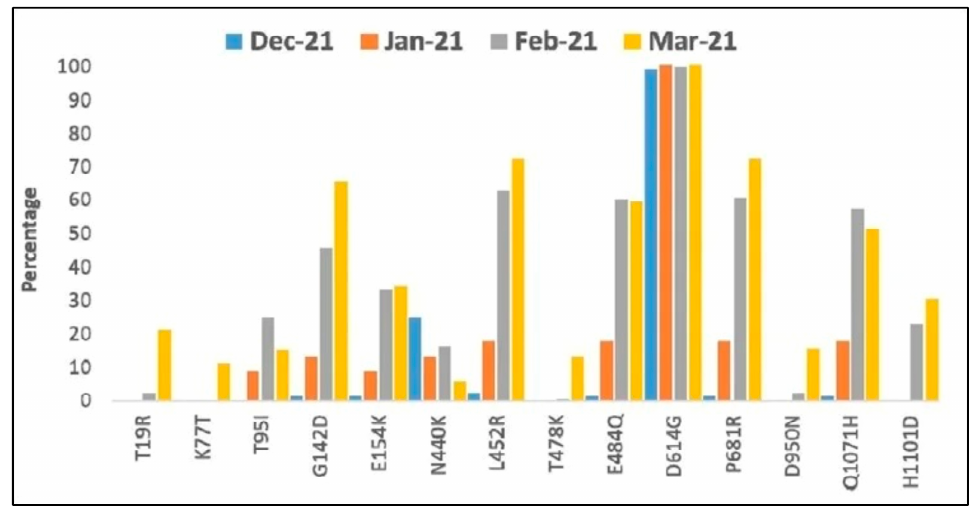
Figure 3. Trend of major mutations in the spike protein from December 2020 to March 2021. [Source: https://www.news-medical.net/news/20210427/Triple-mutation-in-SARS-CoV-2-seen-in-second-wave-of-COVID-19-in-India.aspx, accessed on 15 January 2023].